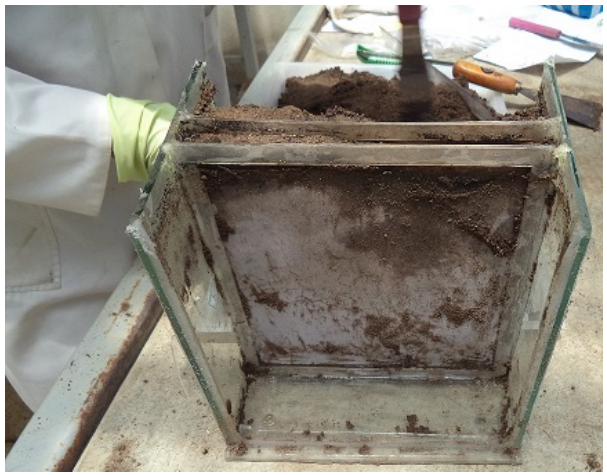
Figure 2. Schematic of rhizosphere soil harvest.